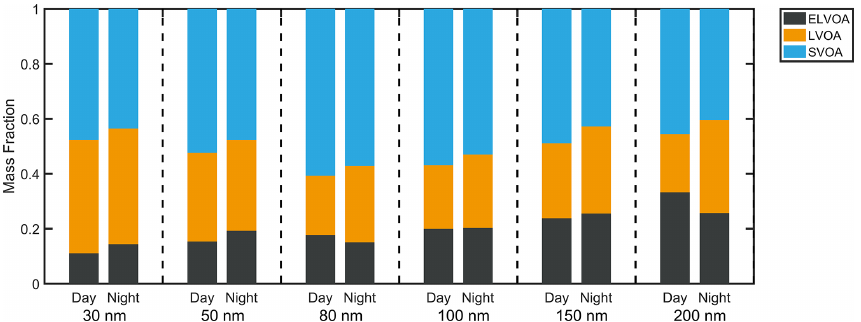
Figure 7. The size-resolved volatility distribution during daytime (08:00–16:00LT) and nighttime (20:00 to 04:00LT) based on the median time of each cycle owing to the limited time